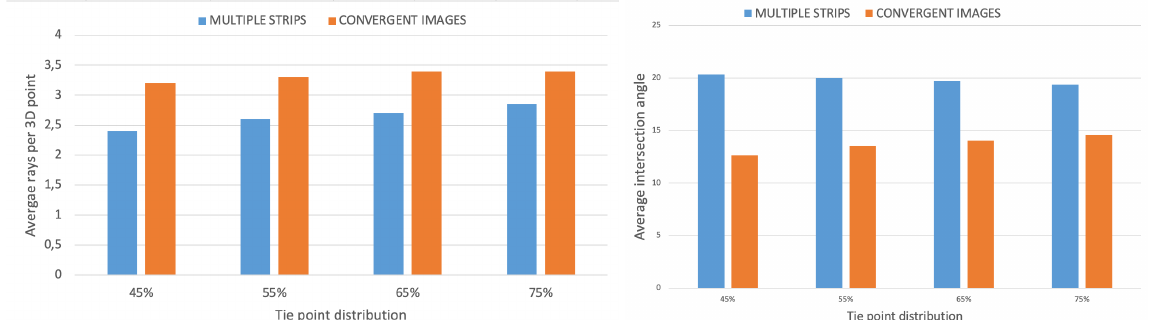
Figure 13. Average intersecting rays per computed 3D points (a) and average intersection angles